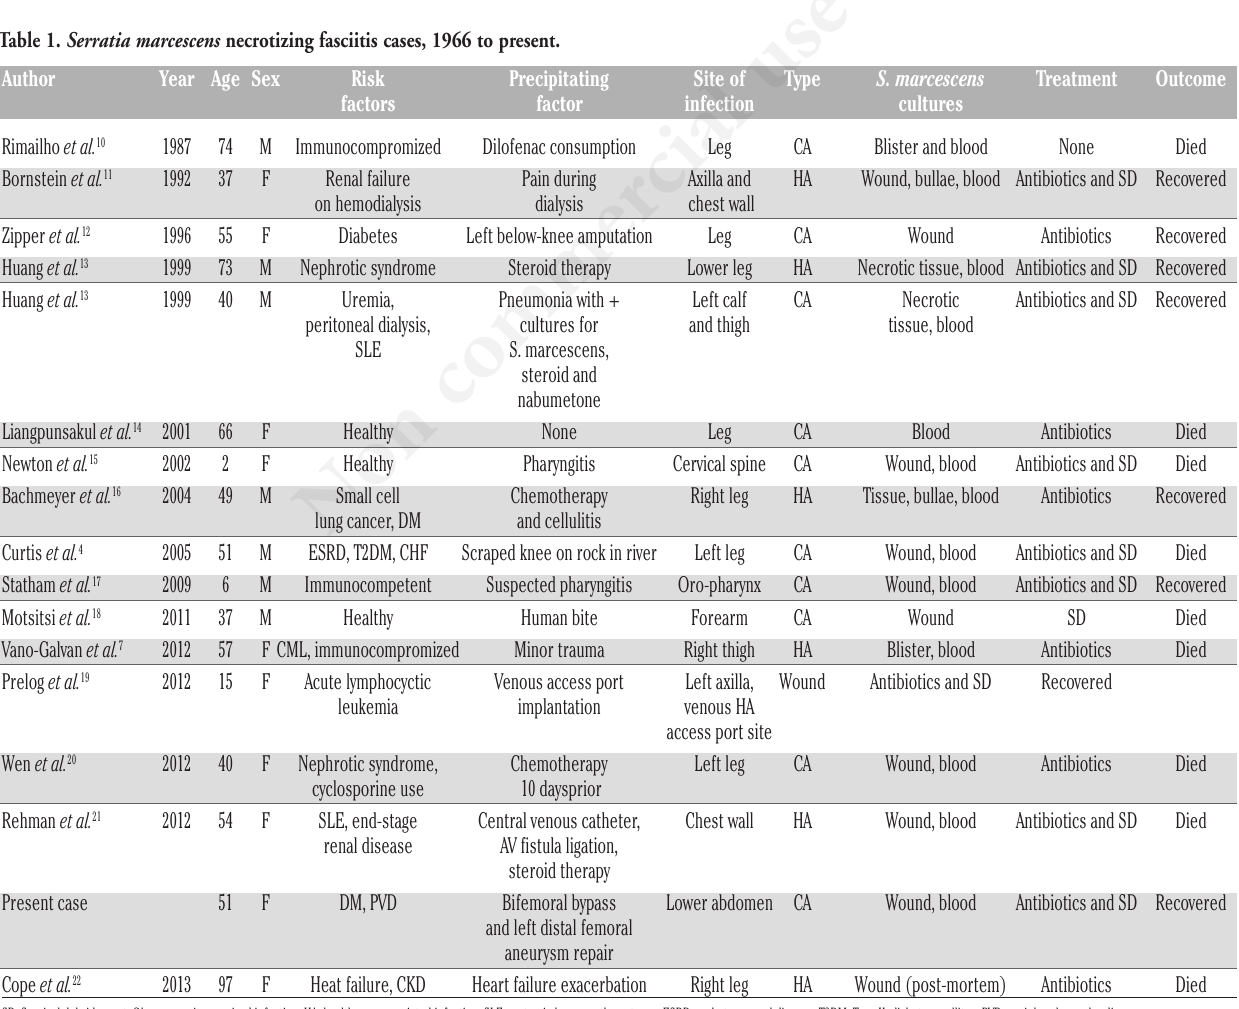
Table 1. Serratia marcescens necrotizing fasciitis cases, 1966 to